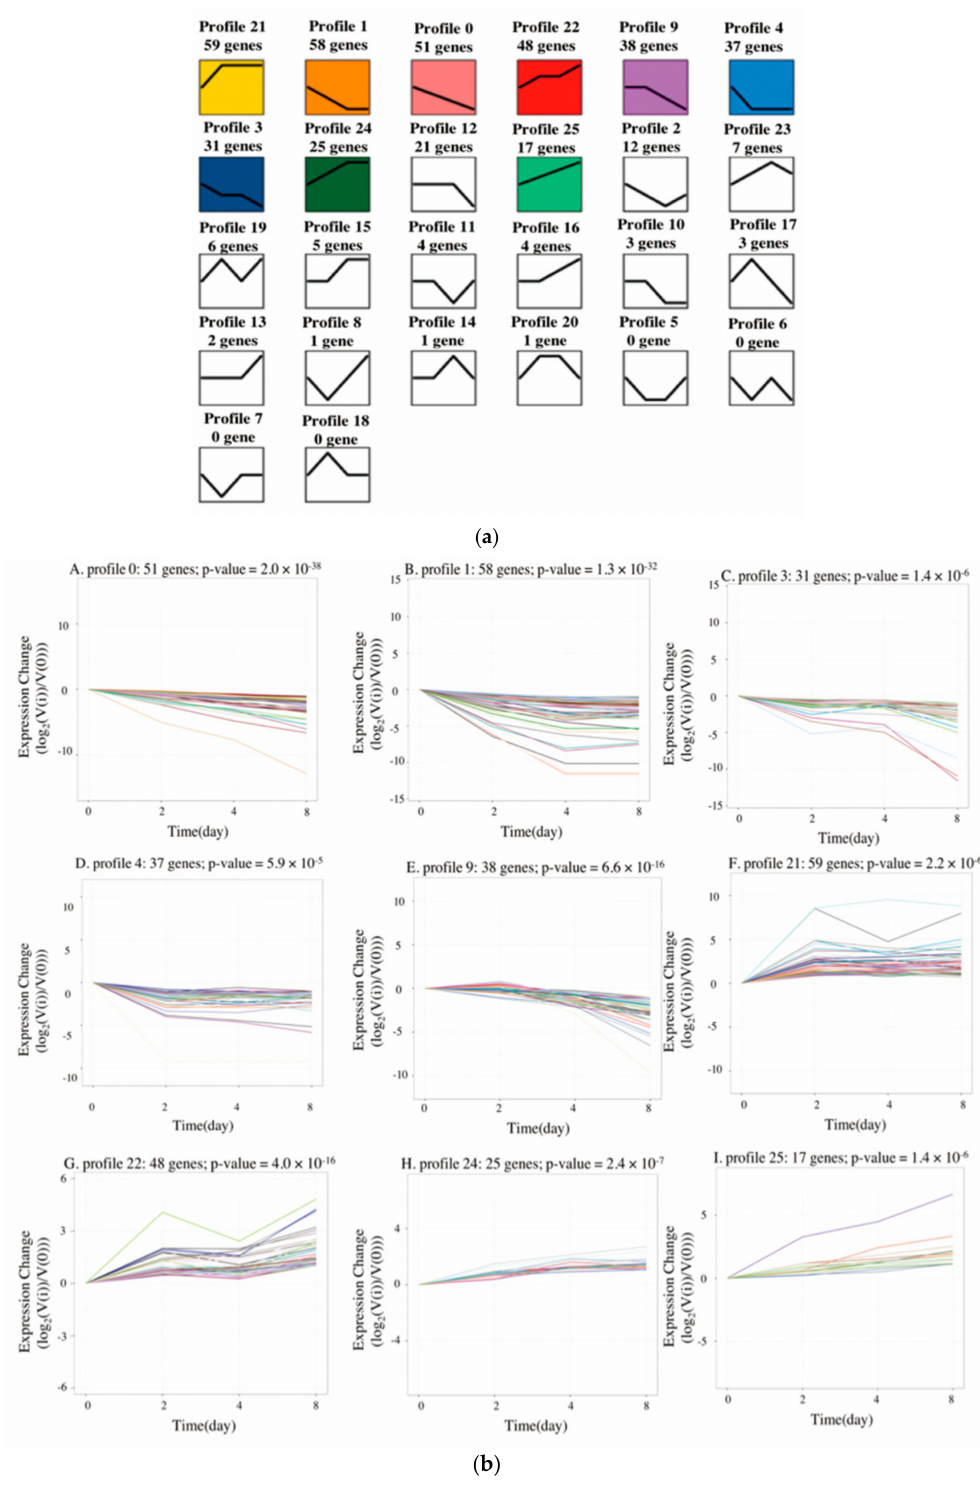
Figure 4. Short time-series expression miner (STEM) clustering on DEGs during preadipocyte di ff erentiation. ( a ) All 26 profiles, with the number of genes shown. Colored profiles were significant ( p < 0.05). ( b ) Nine significant gene expression profiles. Significant gene expression profiles resulting from c = 2 and m = 50 (c indicates maximum unit change in model profiles between time points; m indicates maximum number of model profiles) are displayed as time-course plots of log2 gene expression ratios on days 2, 4, or 8 vs. day 0. The number of genes and the p -value in each profile are shown. Time is shown in